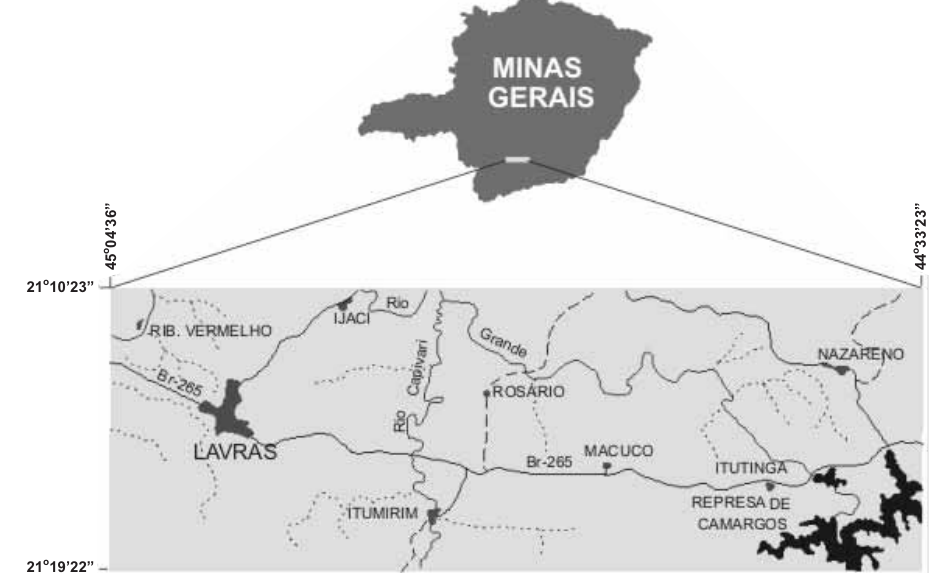
Figura 1. Mapa de localização da área estudada.